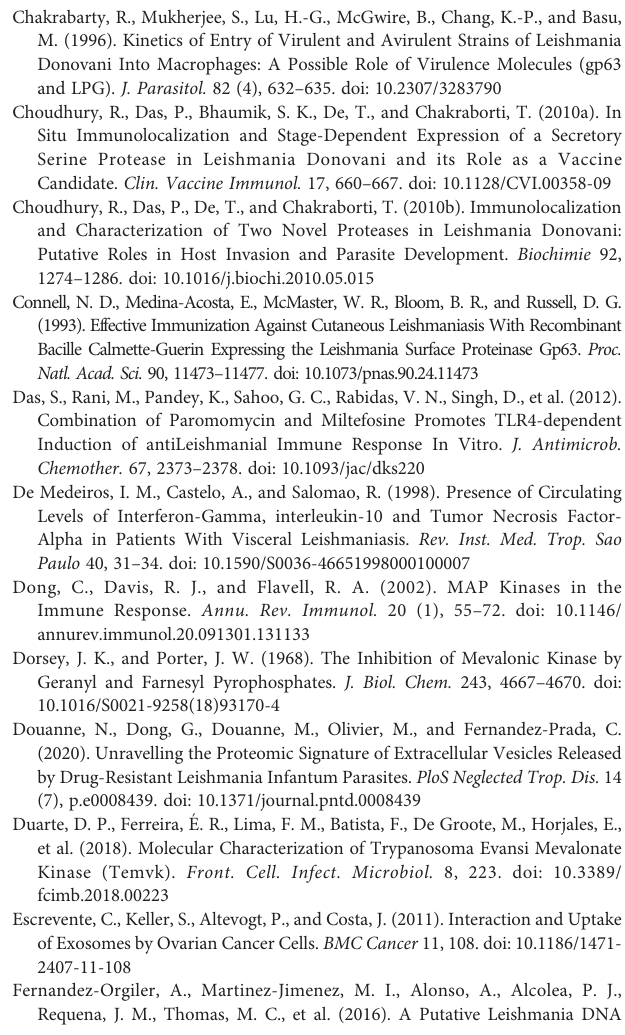
Supplementary Figure 1 | Various parameters forstructurevalidation. (A) Structure ofLdMVKdepicting a -helix, b -sheet,andturnregionsillustratedindistinct colors, and representingthreepredictedN-linkedglycosylationsites(N130,N137,N222),andone O-linked glycosylation site (S228). (B) Stereochemical properties of the homology modelwereinvestigatedinRamachandranplotusingPROCHECKanalysis. (C) ProSA